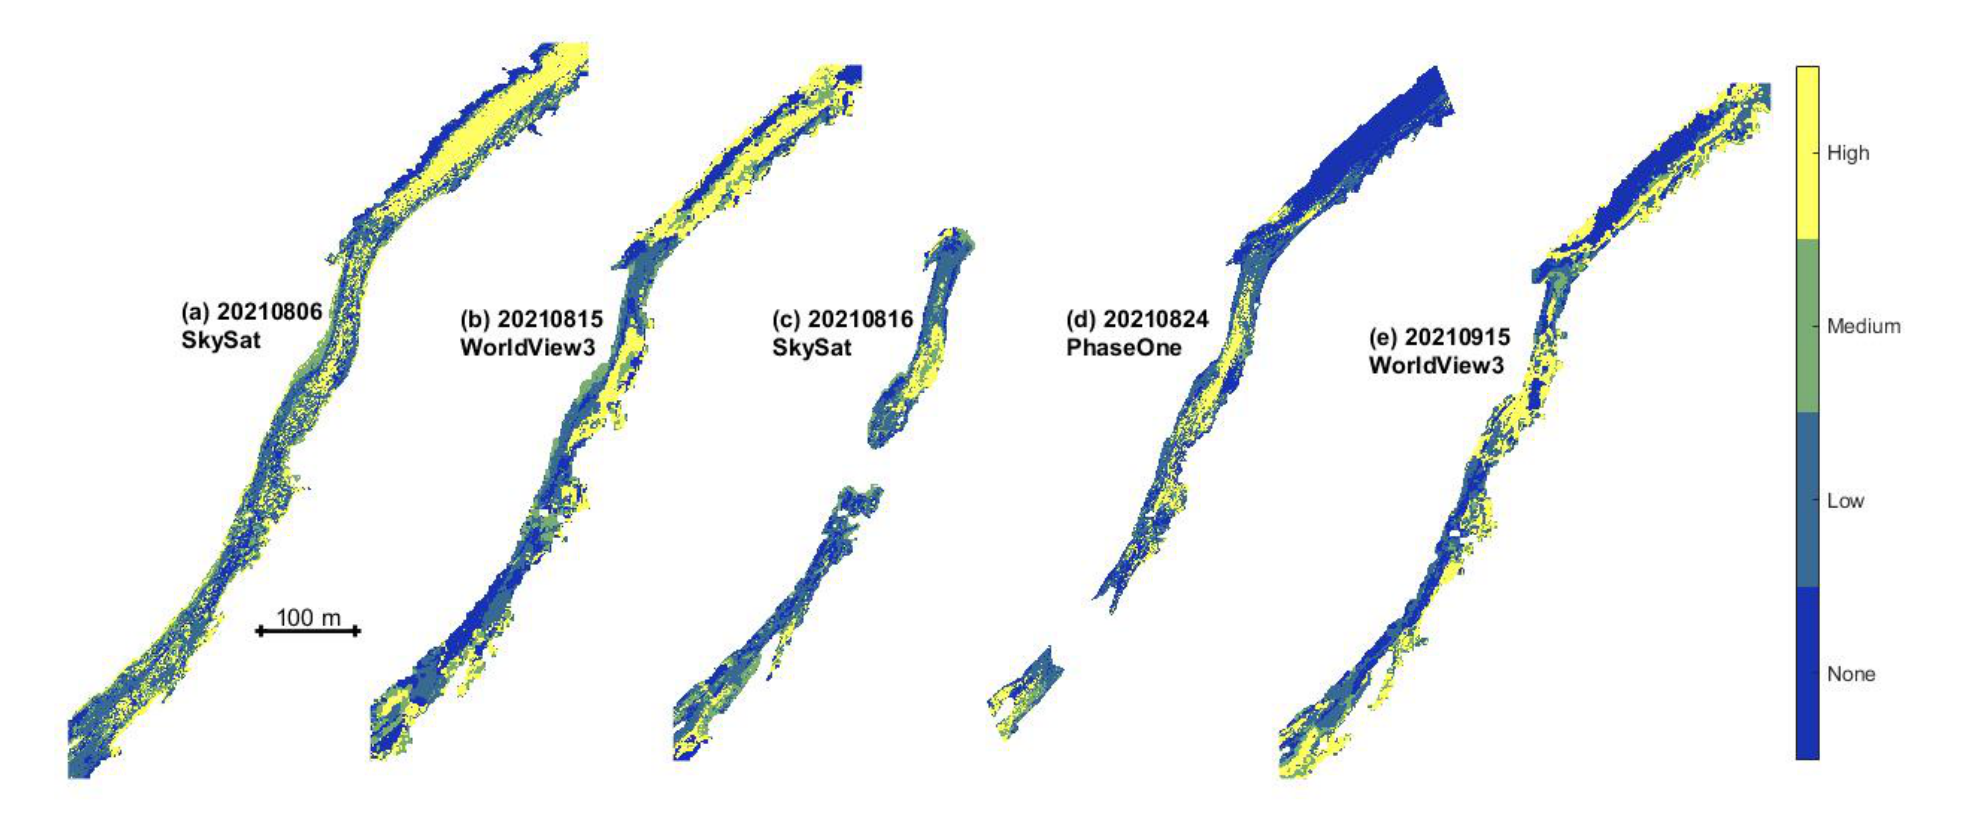
Figure 10. Time series of algal density classification maps produced from various images of the Gilbert reach of the Buffalo River. ( a ) SkySat image from 6 August 2021; ( b ) WorldView3 image from 15 August 2021; ( c ) SkySat image from 16 August 2021; ( d ) PhaseOne image from 24 August 2021; ( e ) WorldView3 image from 15 September